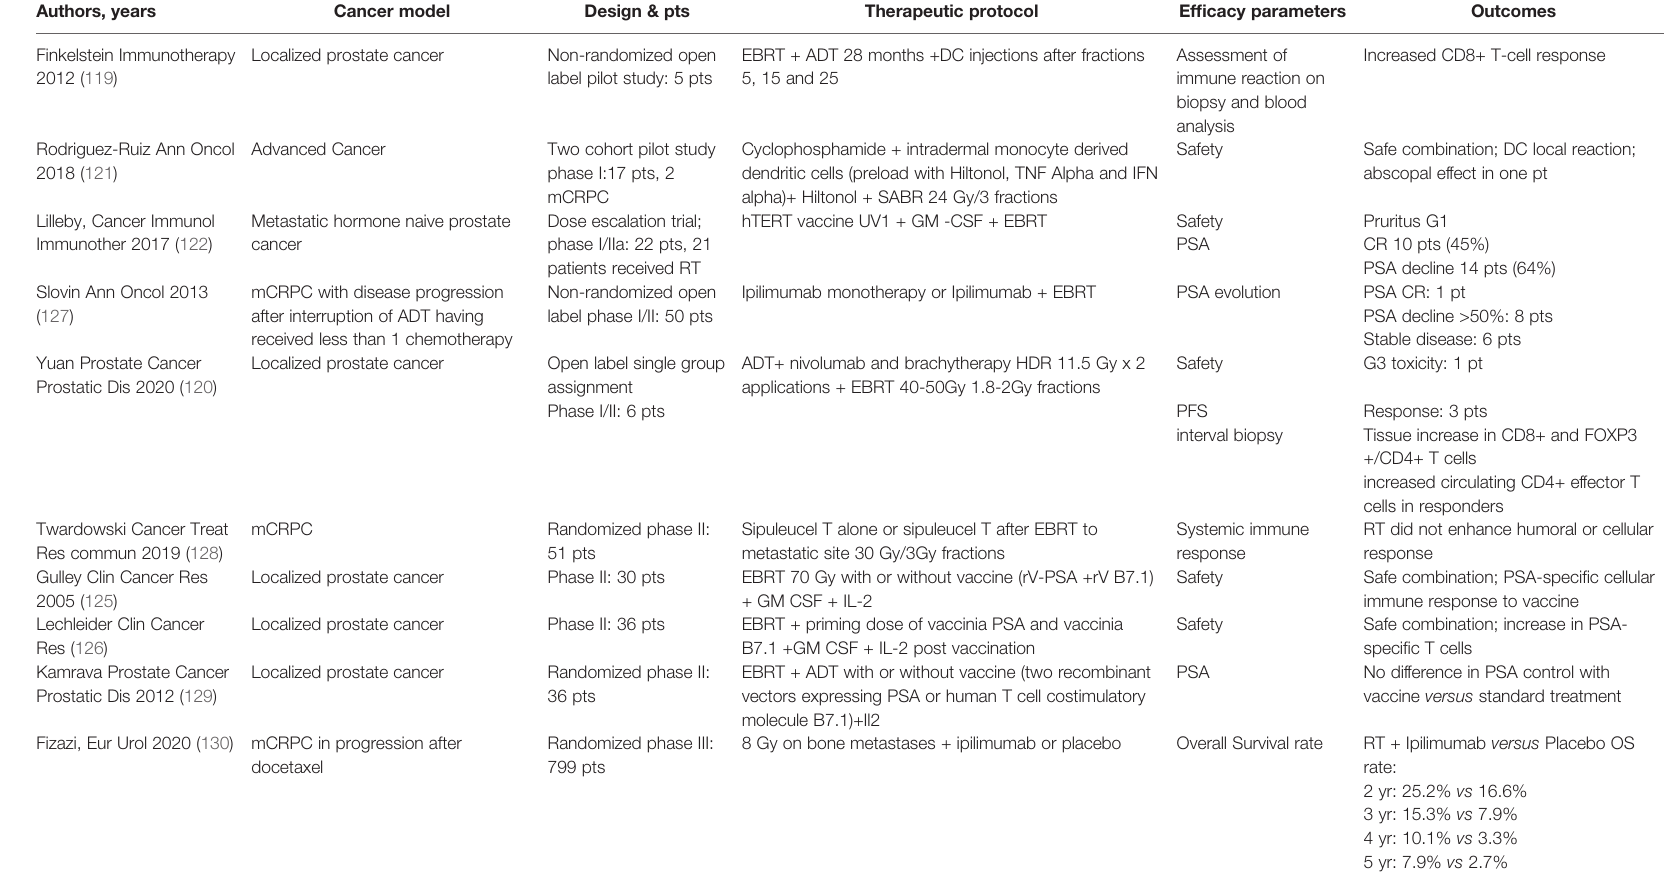
TABLE 2 | Clinical studies reporting radiotherapy and immunotherapy in patients with prostate